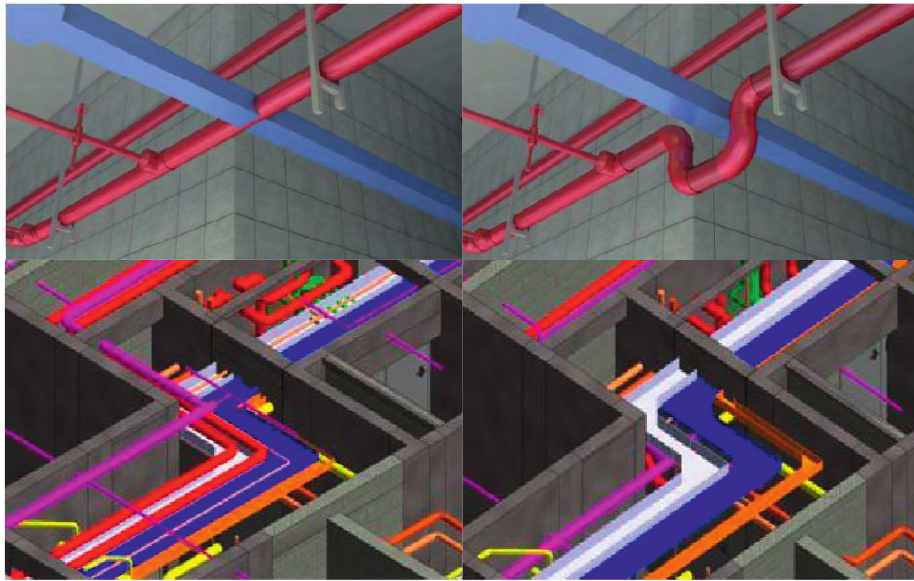
Figure 6: Clash detection and correction using BIM.